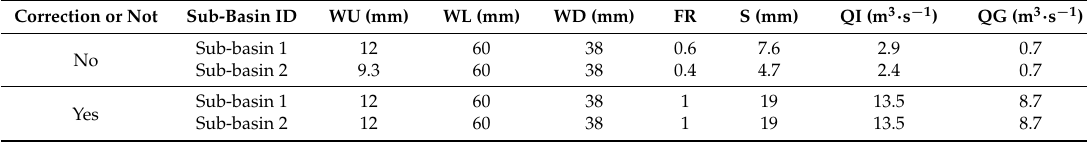
Table 20. The initial state variables of the flood 1992070315 in Zhongzhou Basin.